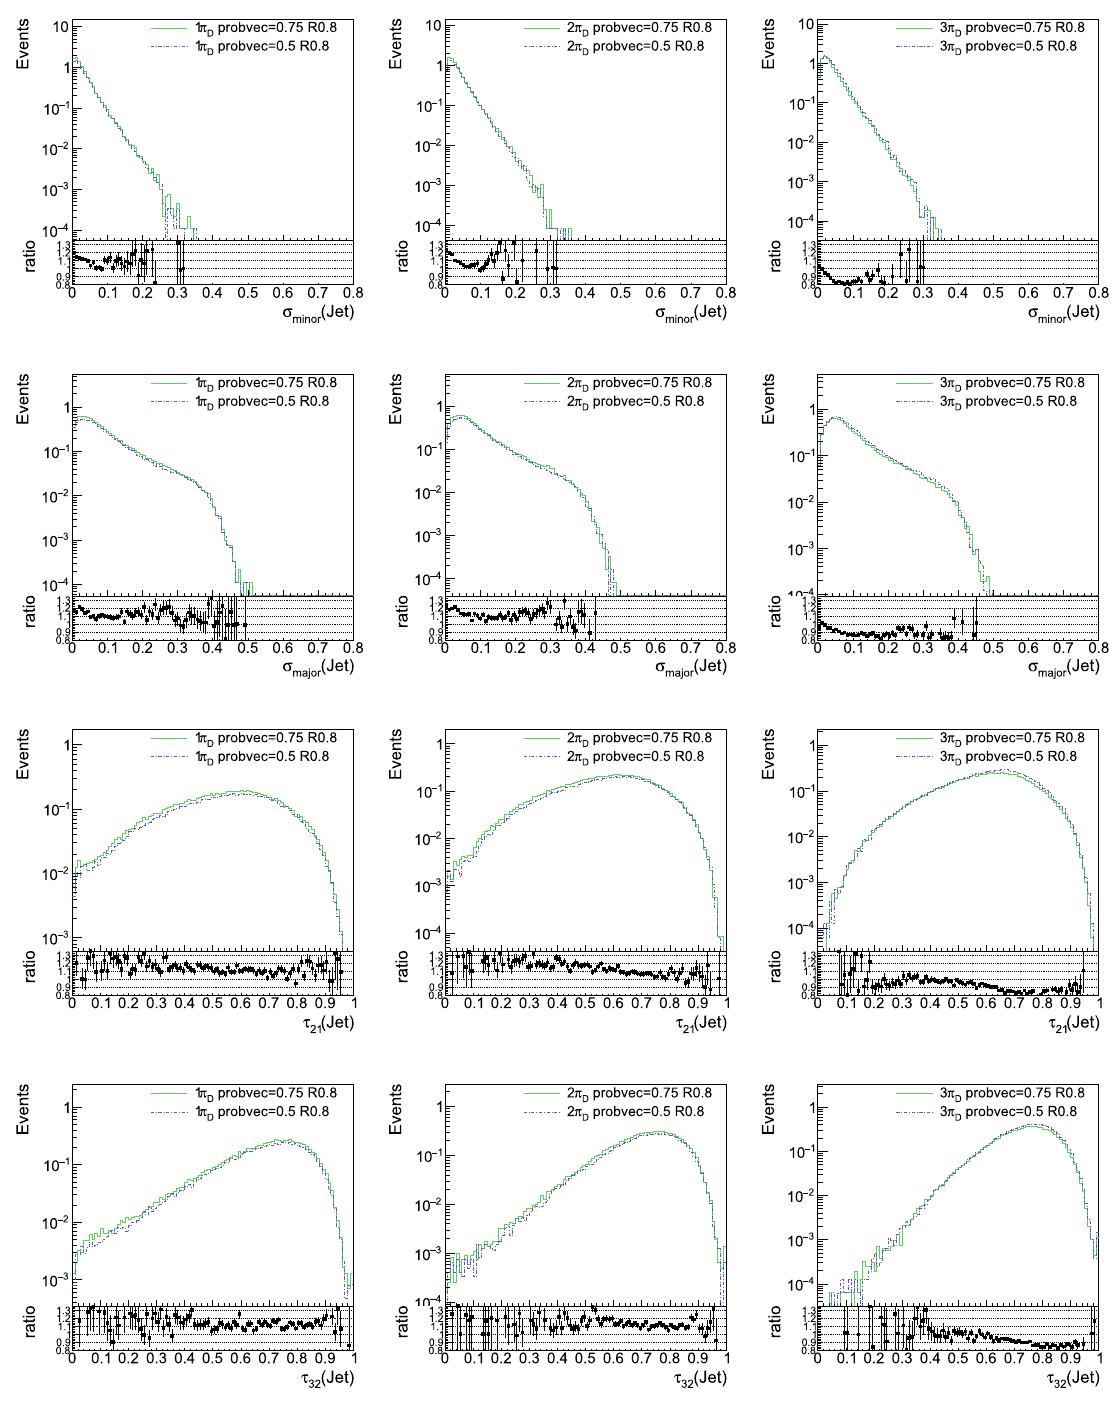
Fig. 47 Comparison of reco-level variables between probVector=0.5 and probVector=0.75 for different number of unstable diagonal dark pions. The first row shows the minor axis, the